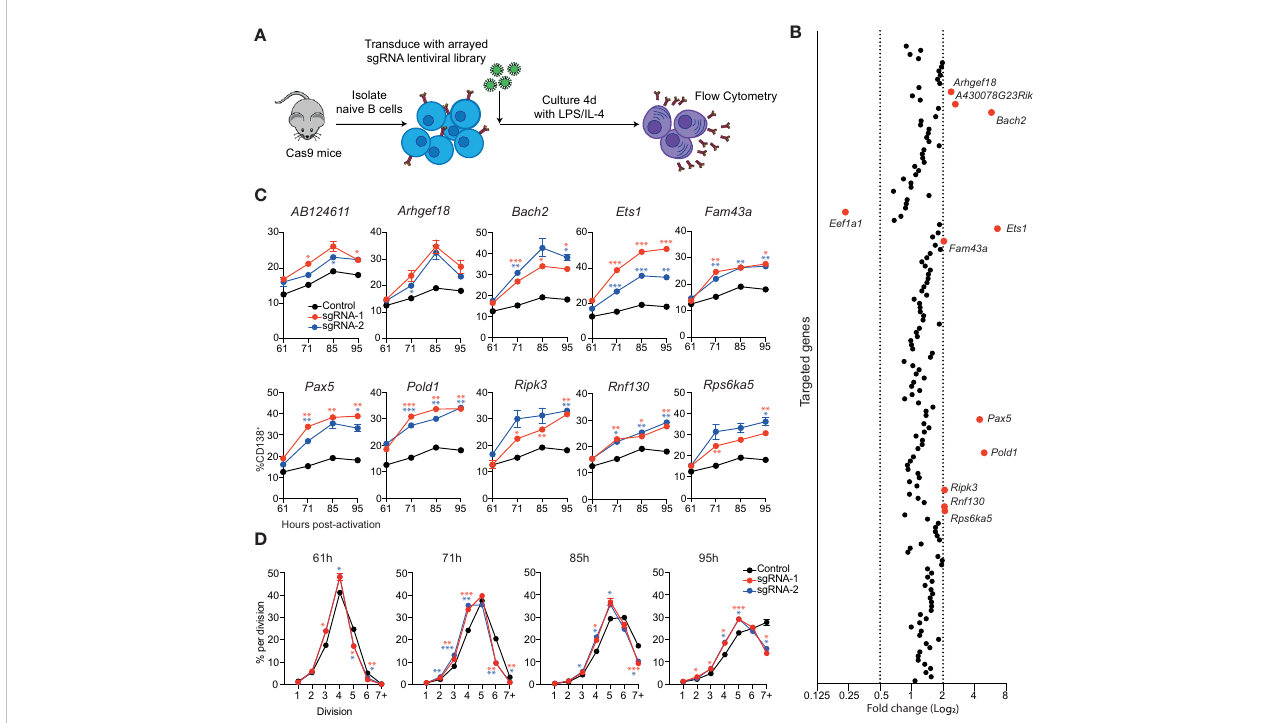
FIGURE 2 Identi fi cation of genes that repress ASC differentiation in vitro. (A) Overview of experimental work fl ow for targeted arrayed CRISPR/Cas9 screen. Naïve splenic B cells were isolated from Cas9 expressing transgenic mice and transduced with an arrayed lentiviral sgRNA library. Following transduction, cells were cultured in LPS + IL-4 for 4 days before analysis by fl ow cytometry. (B) Each data point represents the average fold change in the proportion of transduced cells (BFP + ) that are CD138 + for both sgRNAs targeting a particular gene relative to the untransduced controls on the same plate. Genes with a fold change of ≤ 0.5 or ≥ 2 are labelled and highlighted in red. Data points represent the mean of 2 independent sgRNAs from 2 replicate experiments. (C) Naïve B cells from Cas9 transgenic mice were transduced with sgRNAs targeting the indicated genes and cultured in LPS. At the indicated timepoints, the proportion of CD138 + cells within the transduced (BFP + ) population was assessed by fl ow cytometry. (D) Naïve B cells from Cas9 transgenic mice were labelled with the division tracking dye CTY, transduced with sgRNAs targeting Pold1 and cultured in LPS. At the indicated timepoints, the dilution of CTY within the transduced (BFP + ) population was assessed by fl ow cytometry. Data points represent the mean of triplicate wells and error bars indicate the S.E.M. (C, D) are representative of 2 independent experiments. *p < 0.05, **p < 0.01, ***p <